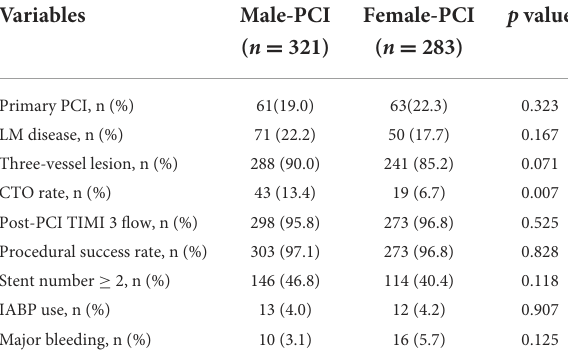
TABLE 2 Coronary artery characteristics of patients in the PCI group.